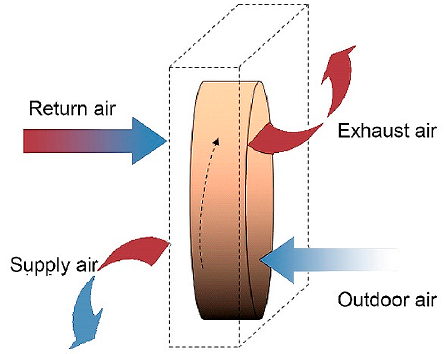
Figure 2. Diagram of rotary wheel heat exchanger working mode [7].